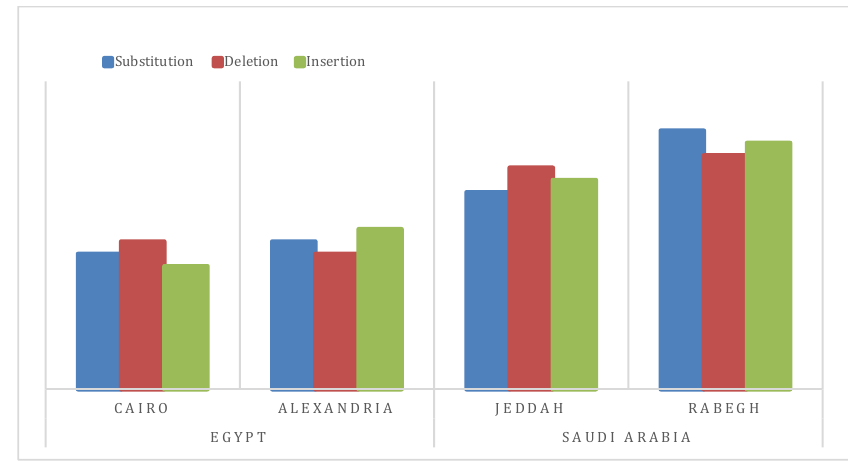
Figure 6. Speak Correct errors for each locality.